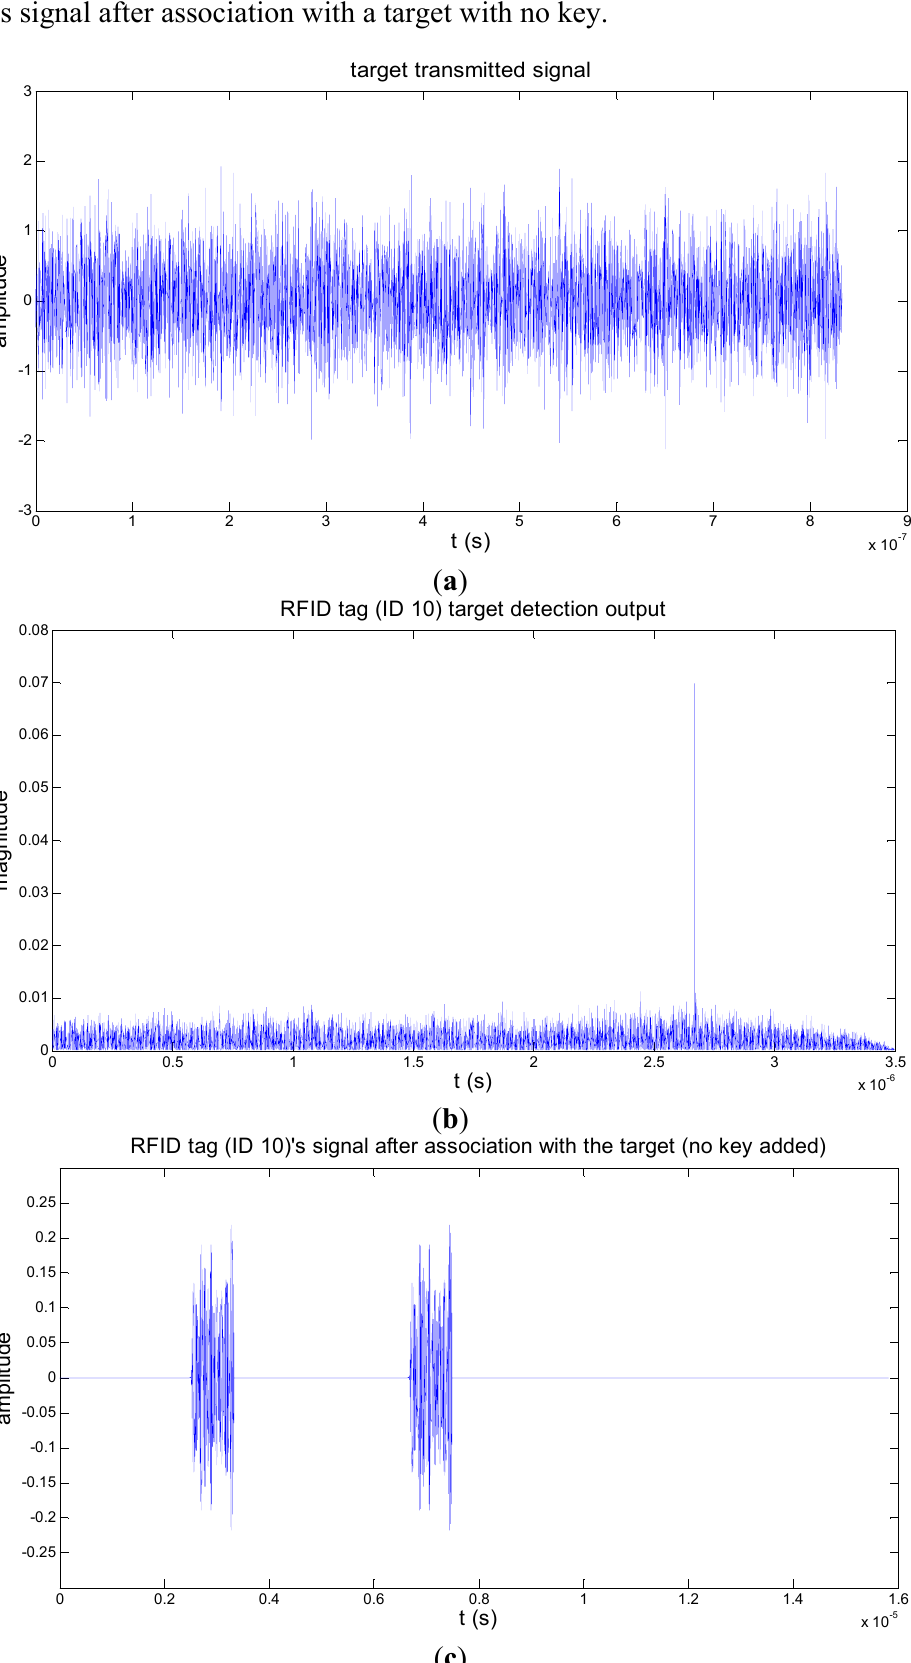
Figure 4. Target association simulation illustration. ( a ) noise signal transmitted by the target; ( b ) correlation output of RFID tag (ID 10) indicating target detection; ( c ) RFID tag (ID 10)’s signal after association with a target with no